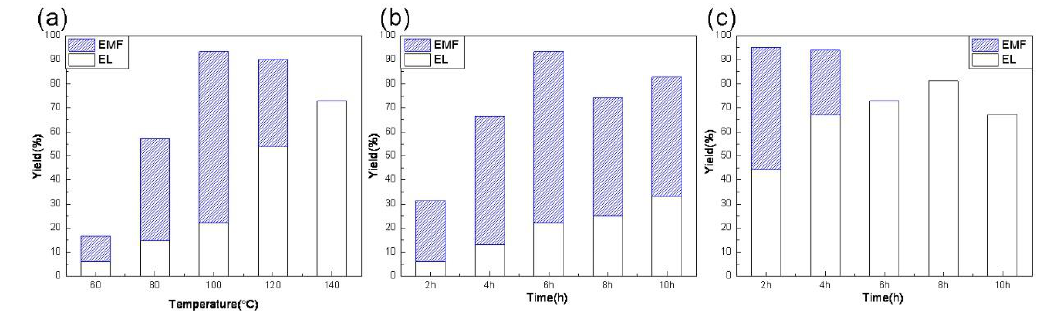
Figure 4. Influence of temperature and time on the reaction. ( a ) Catalytic performance of the catalyst at different temperatures for 6h. ( b ) Catalytic performance of the catalyst at 100 °C for different lengths of time. ( c ) Catalytic performance of the catalyst at 140 °C for different lengths of time.